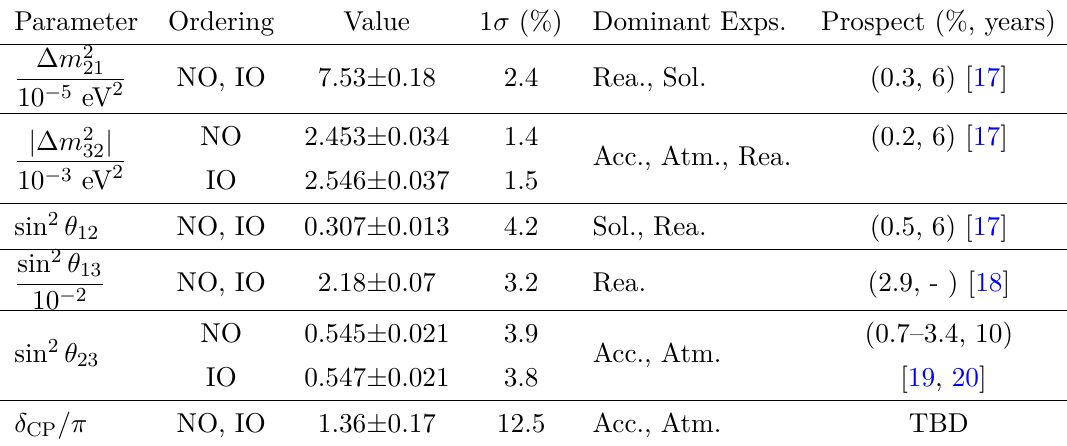
Table 1 . Current relative precision estimation of the oscillation parameters from PDG2020 [4] and the projected precision in the near future with corresponding data taking time. The 1 σ relative uncertainties and the dominant types of experiments (Exps.) are also listed. The reactor experi- ments (Rea.) measure sin 2 θ 13 and ∆ m 2 with the highest precision. The solar experiments (Sol.) 21 contribute a lot to the sin 2 θ 12 and ∆ m 2 determination. The accelerator (Acc.) and atmospheric 21 experiments (Atm.) dominate the measurements of sin 2 θ 23 , ∆ m 2 , and δ CP . The estimation for 32 both normal ordering (NO) and inverted ordering (IO) are